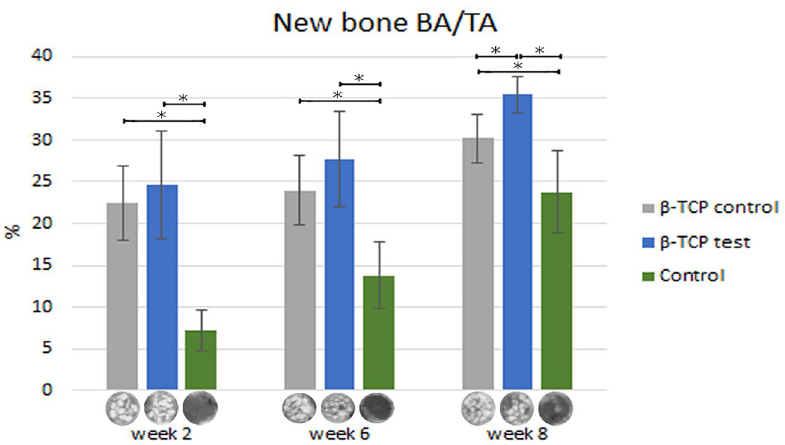
Figure 10. Micro CT new bone formation (SKYSCAN 1076, Antwerp, Belgium). Statistically significant difference was indicated by * ( P < 0.05).